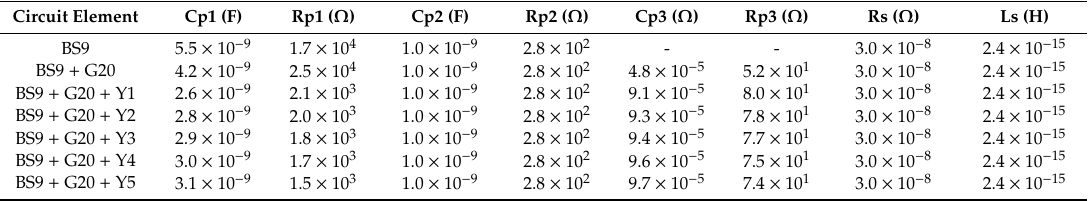
Table A13. Modeled impedance parameters Cp1, Rp1, Cp2, Rp2, Cp3, Rp3, Rs, and Ls of biochip BS9, with 10% glucose as medium and S. cerevisiae .